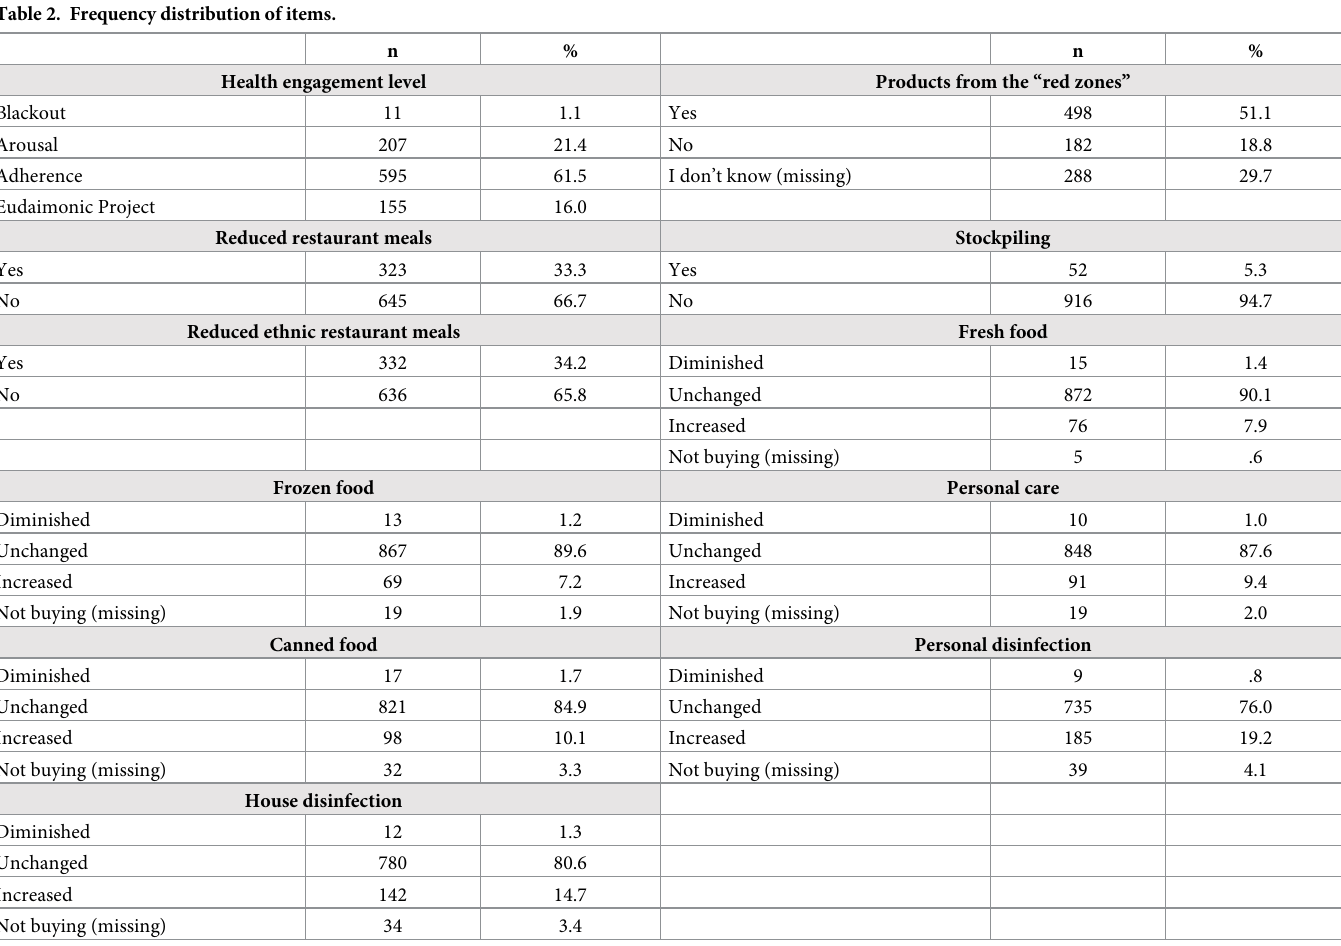
Table 2. Frequency distribution of items.